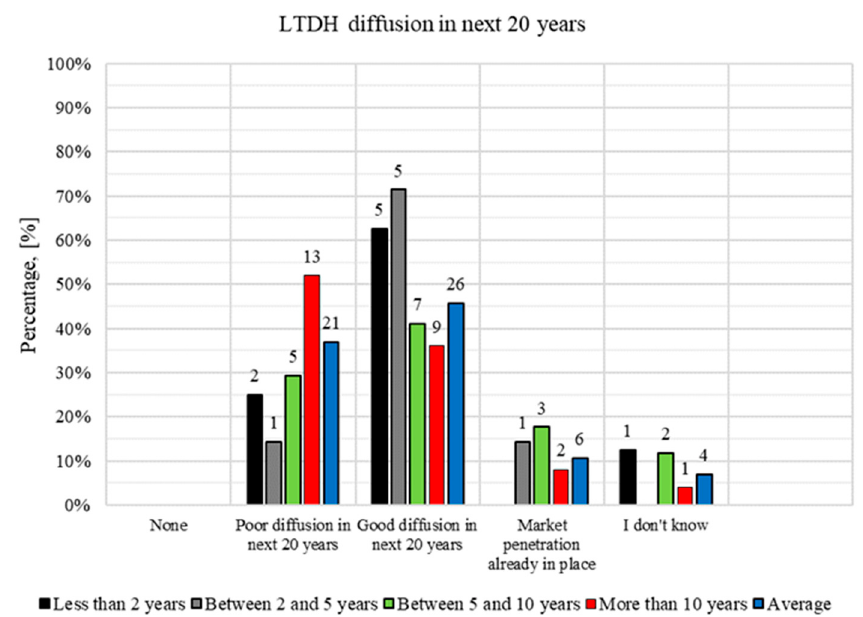
Figure 36 . LTDH concept diffusion over the next 20 years as a function of working experience.